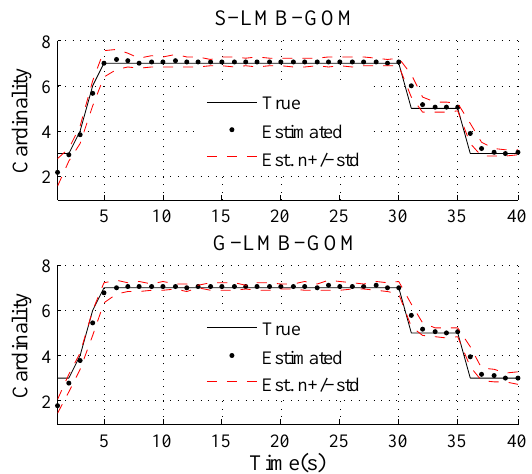
Figure 9. The true and estimated cardinality for S-LMB-GOM filter and G-LMB-GOM filter.